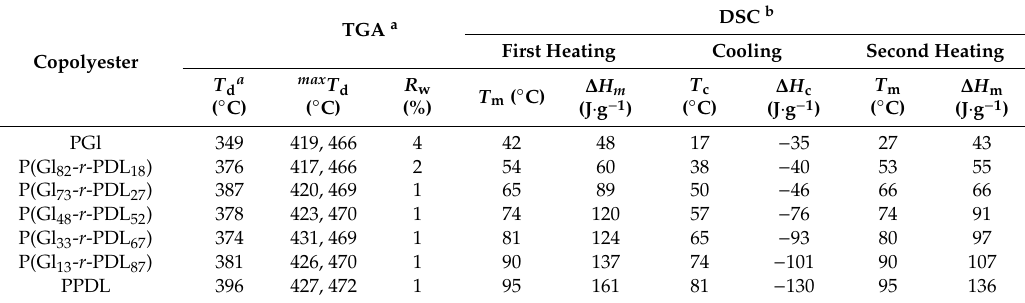
Table 2. Thermal properties of P(Gl x - r -PDL y )